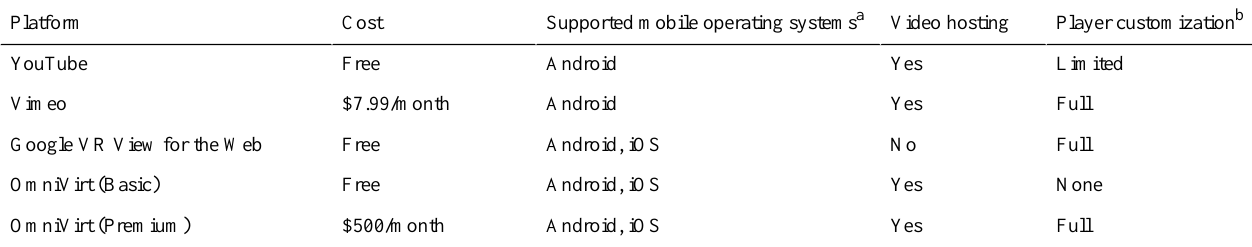
Table 2. Comparison of 360-degree video Web embedding options as of September